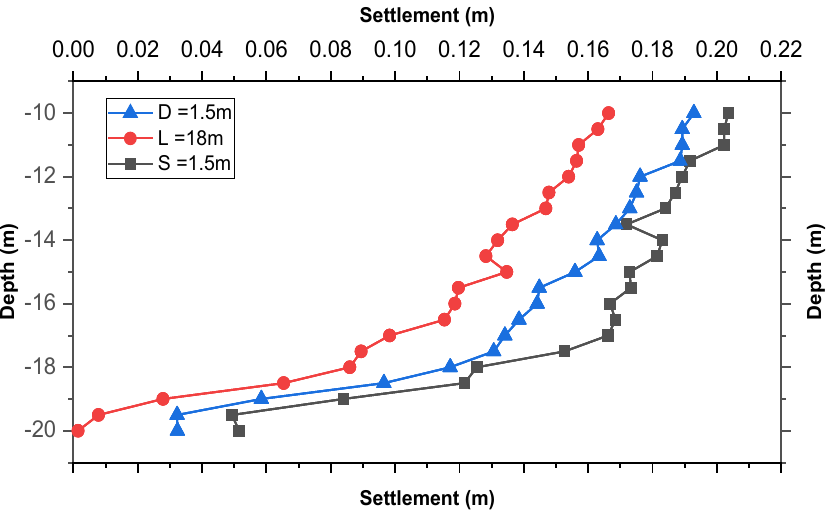
Figure 7: Effect of stone column optimal design parameters on